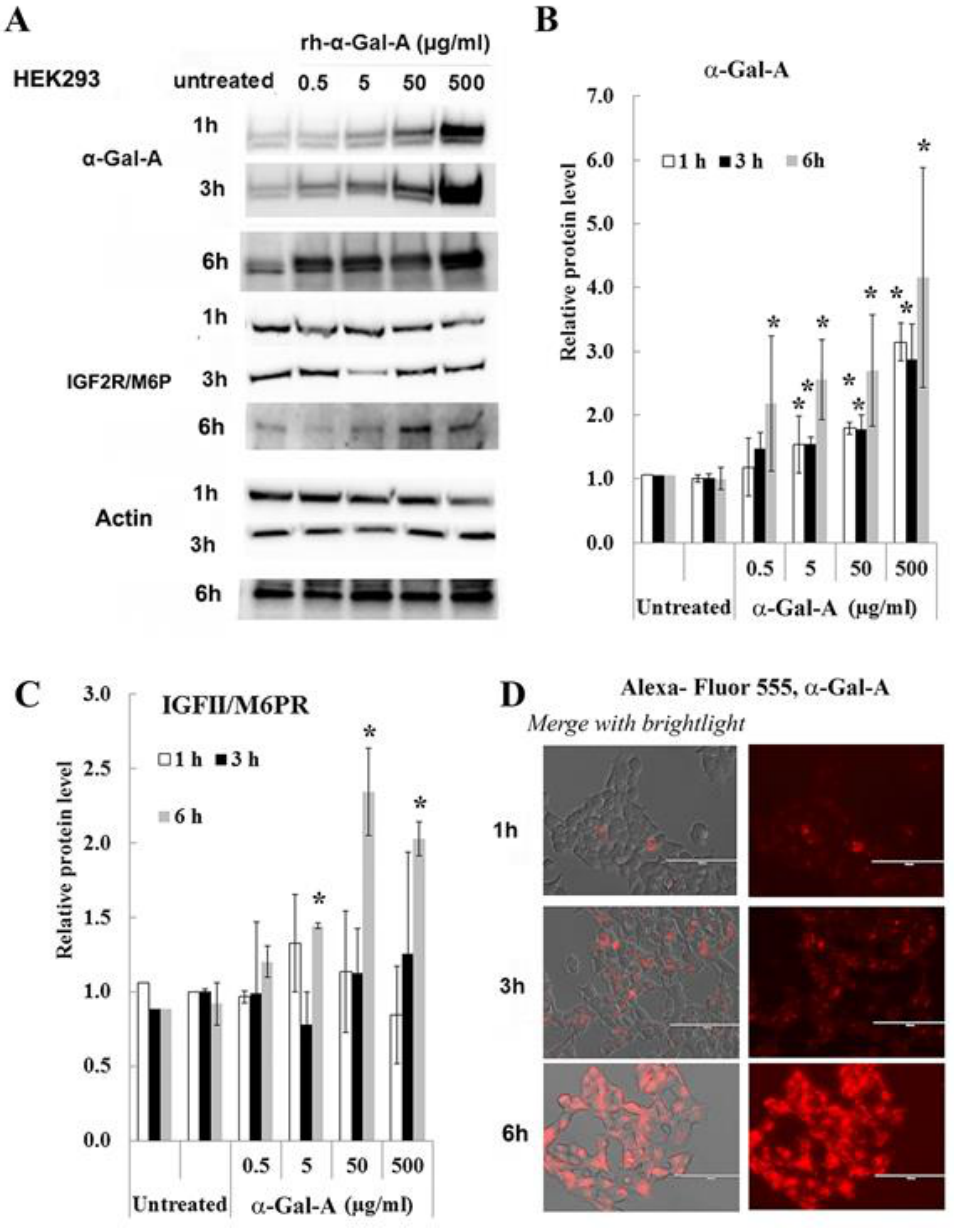
Figure 3. IGF2R/M6P decreases during rapid uptake of rh-α-Gal A. HEK293 cells were treated with the indicated concentrations of rh-α-Gal A for 1, 3, and 6 h. ( A ) Western blot (30 µg WCE) shows that uptake of rh-α-Gal A protein increases in concentration- and time-dependent manners. IGF2R/M6P increased after 6 h treatment. Membranes were reprobed for actin for normalization. ( B ) Quantitation of the relative level of α-Gal A. ( C ) Quantitation of relative level IGF2R/M6P. ( D )) Immunofluorescence images of time course treated HEK293 cells with Alexa-Fluor-α-Gal-A conjugates. Bars: 100 μm.